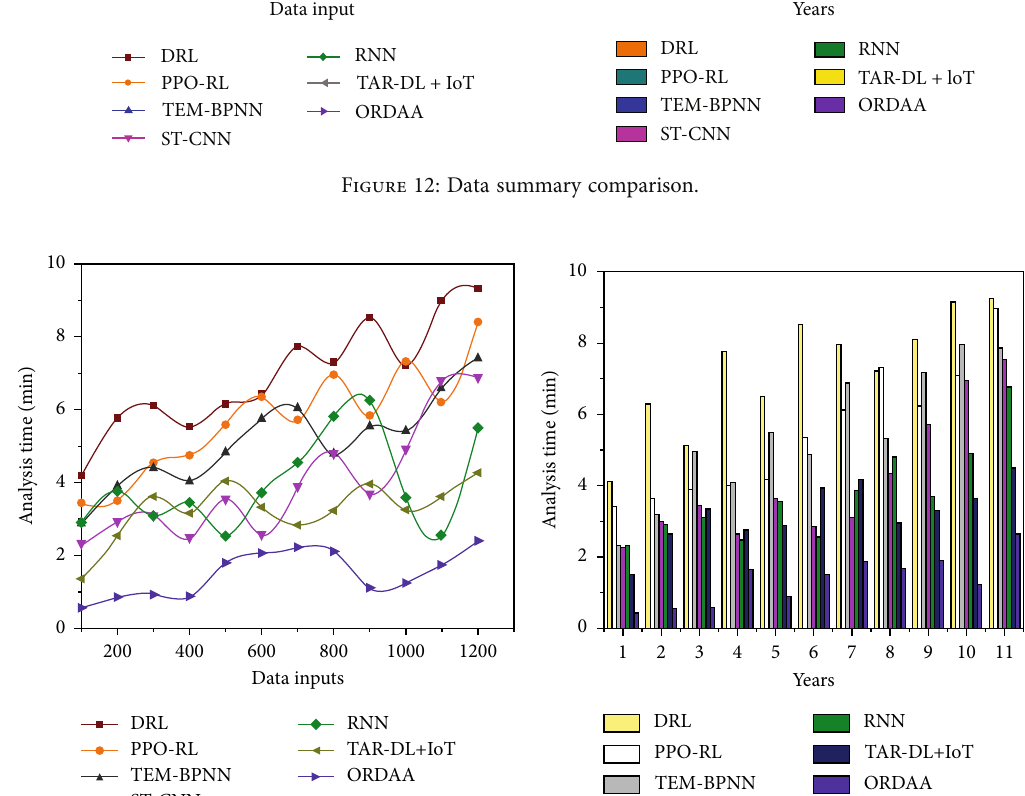
Figure 13: Analysis time comparison.